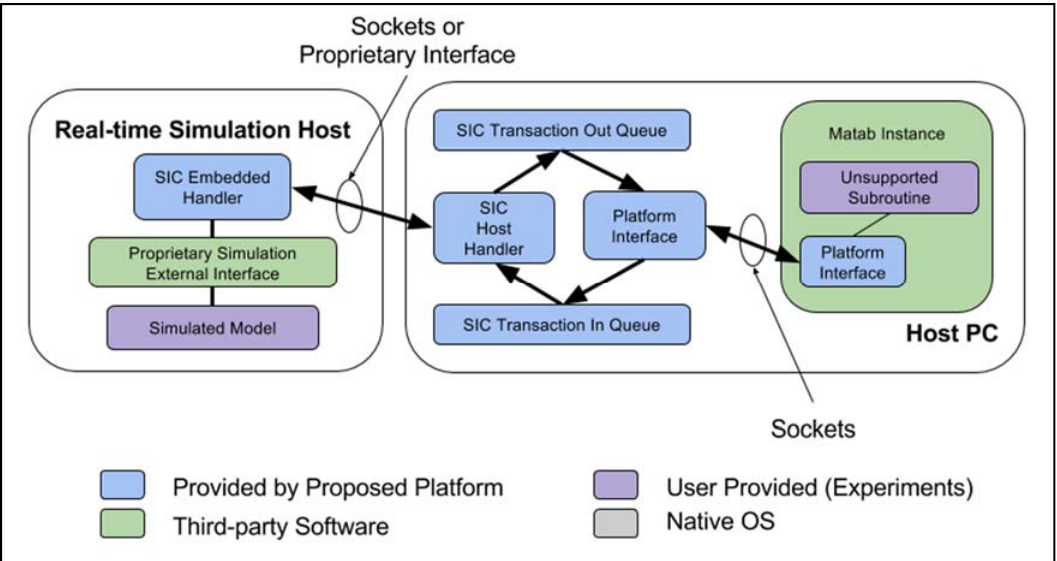
Figure 4. Case 2 Test Environment.